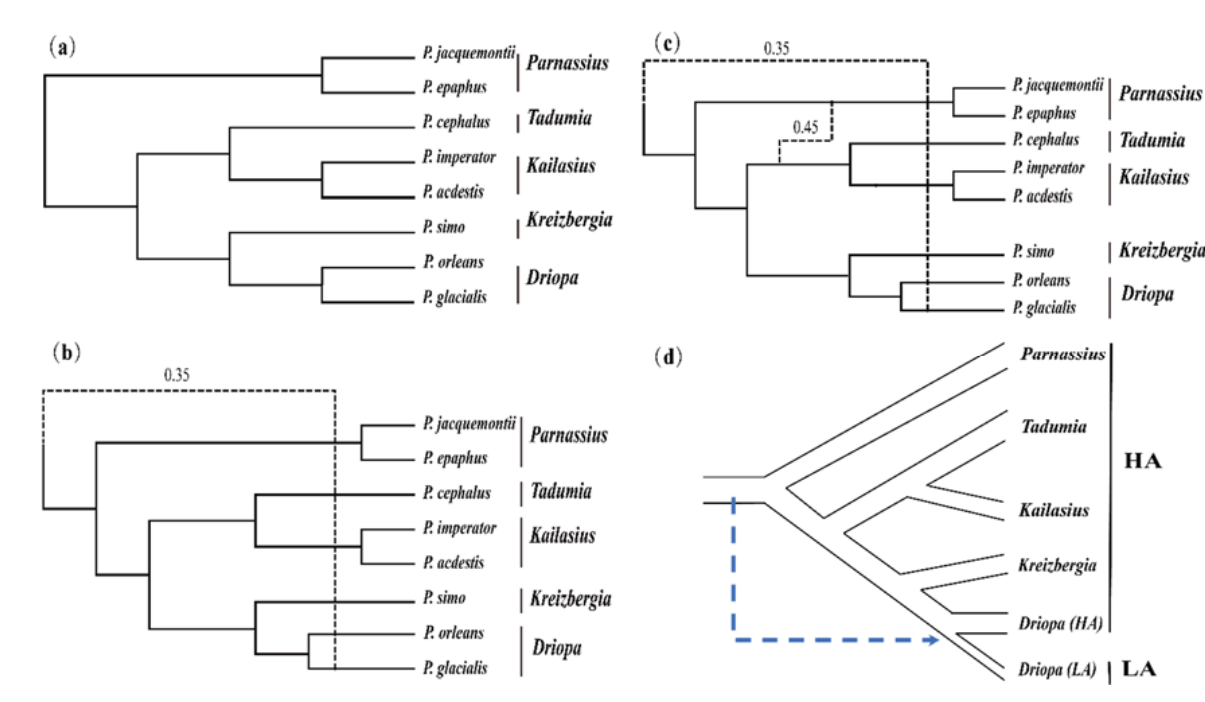
Figure 5. Phylogenetic networks inferred through PhyloNet by using maximum pseudo-likelihood. ( a ) Zero reticulation model. ( b ) One reticulation model. ( c ) Two reticulation model. ( d ) Hypothetical introgression event causing LA divergence. Decimals in figures ( b , c ) are the estimated percentage likelihoods of ancient introgressions with 1896 single-copy